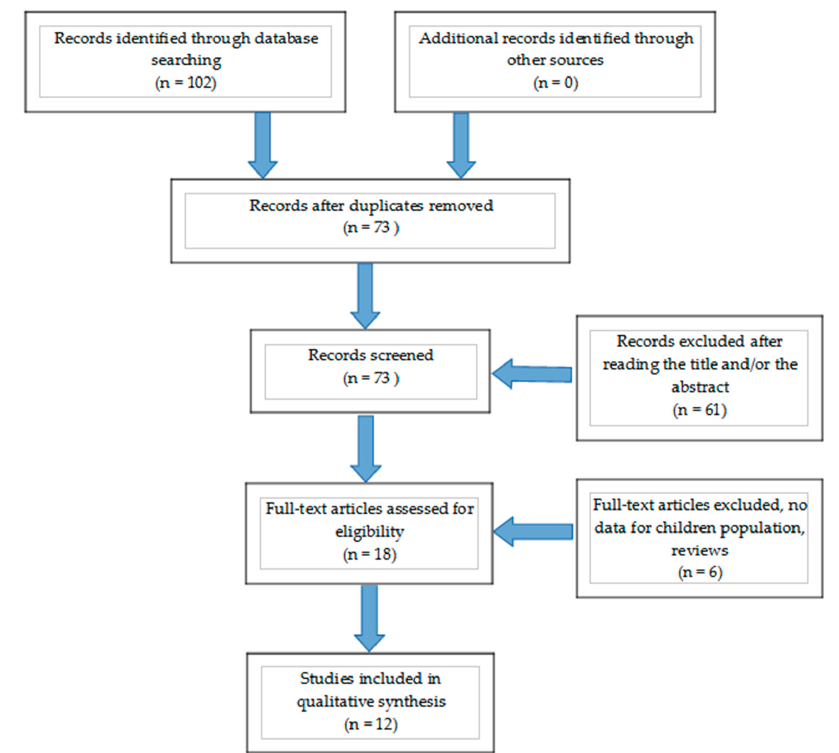
Figure 1. Flow chart describing the step-wise selection (identification, screening, eligibility, inclusion) of the studies included in the qualitative synthesis.